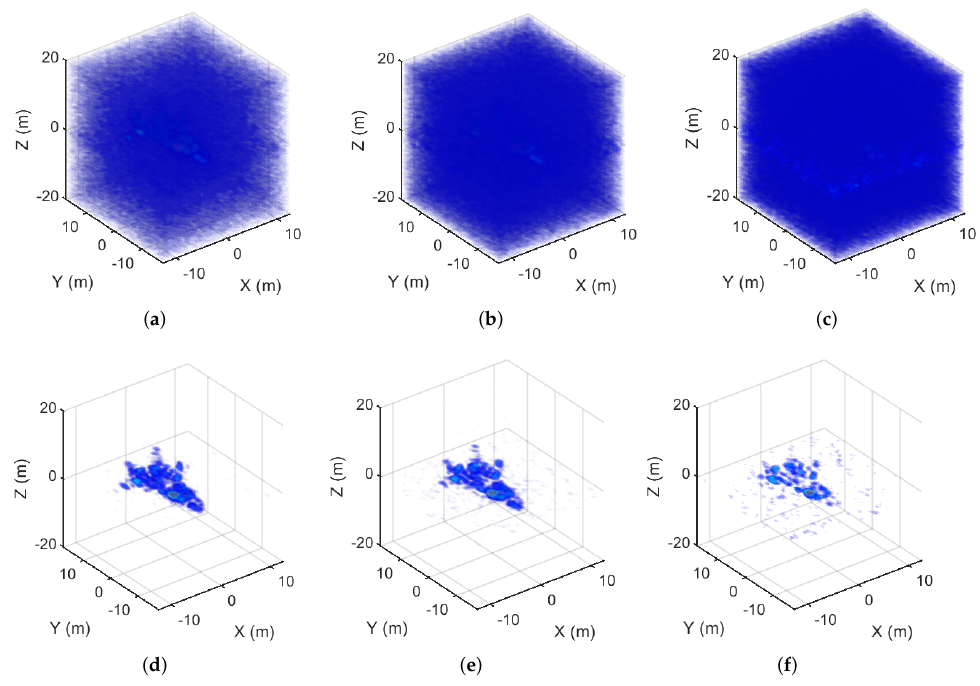
Figure 14. The imaging results of the GMM- L 0.8 . ( a ) The MF result corresponding to the 50% sampling rate. ( b ) The MF result corresponding to the 25% sampling rate. ( c ) The MF result corresponding to the 10% sampling rate. ( d ) The GMM- L 0.8 result corresponding to the 50% sampling rate. ( e ) The GMM- L 0.8 result corresponding to the 25% sampling rate. ( f ) The GMM- L 0.8 result corresponding to the 10% sampling